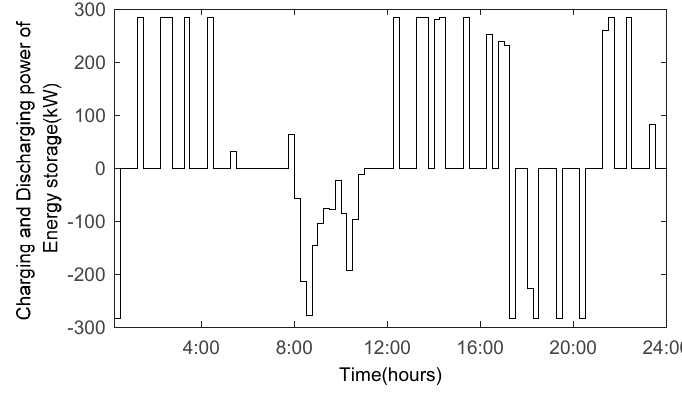
Figure 10. Charging and discharging power of VRLA.